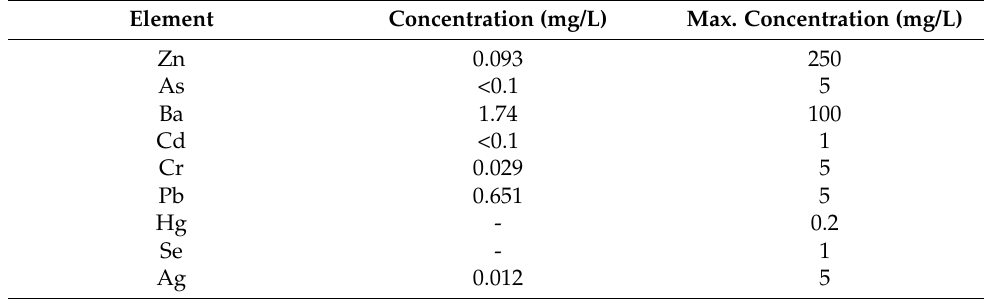
Table 6. Concentration of elements in the leachate compared to the TCLP standard.